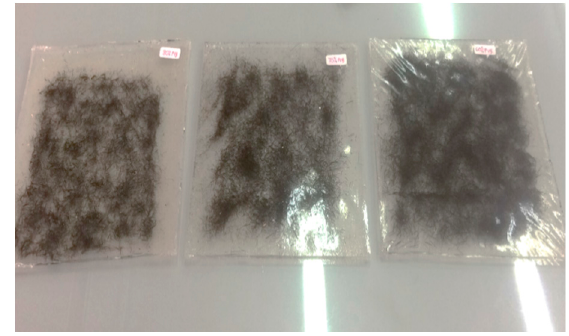
Figure 3. Samples of laminate’s composites for short cut SPF .